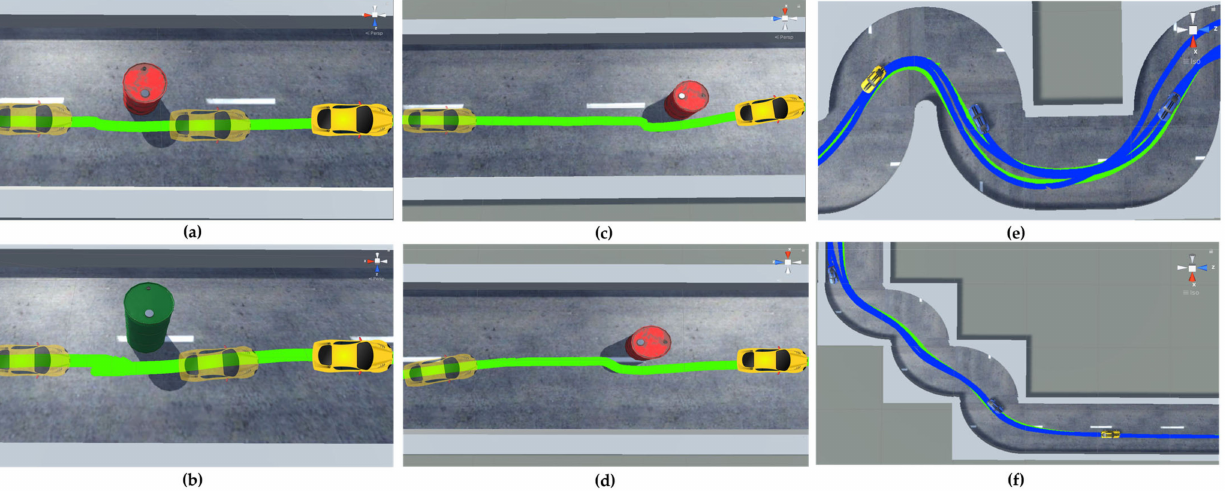
Figure 17. The actual effect of virtual vehicle autonomous driving in different types of obstacle environments. ( a , b ) are the effects of different types of obstacles on the autonomous driving strategy of virtual vehicles, ( c , d ) are the effects of obstacles in different positions that generate penalty feedback on the autonomous driving strategies of virtual vehicles, ( e , f ) are the actual driving process of two virtual vehicles with conflicting autonomy policies in the autonomous driving